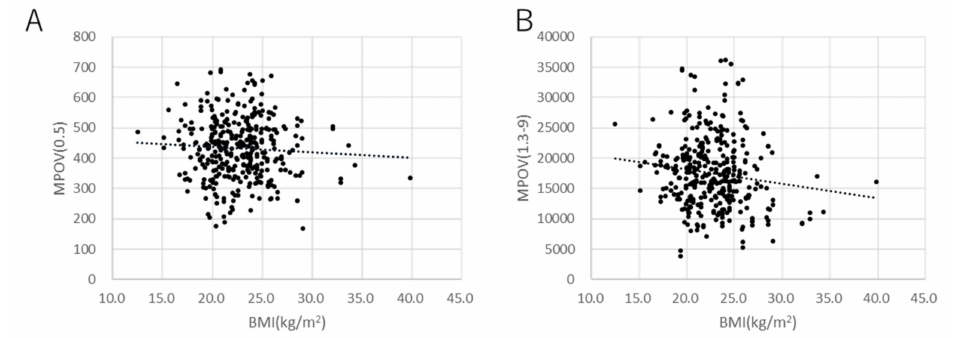
Figure 4. Scatter plots of MPOV against BMI. ( A ) MPOV(0.5) (coefficient = − 2.17, p = 0.30). ( B )